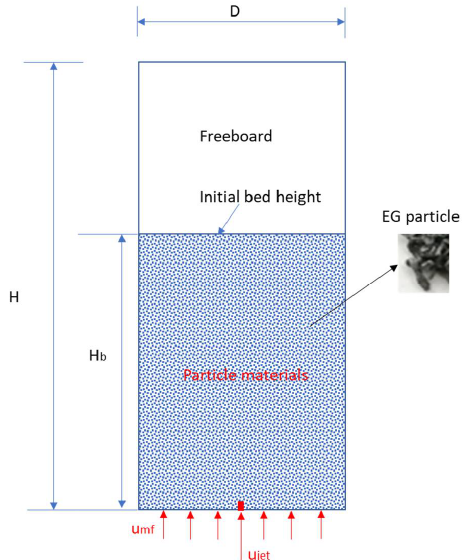
Figure 1. The schematic of bubbling fluidized bed